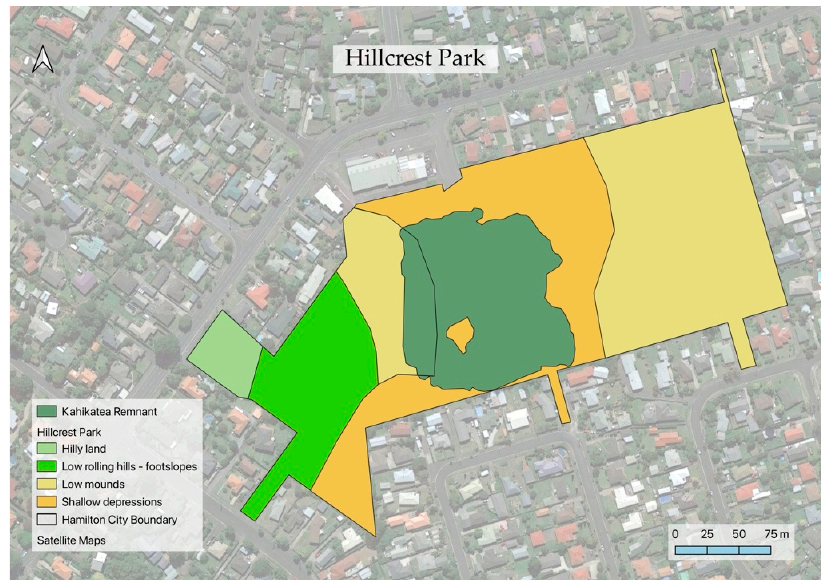
Figure A2. Hillcrest Park’s planting zones. Hilly land (rimu/tawa forest); low rolling hills— footslopes (pukatea-kahikatea forest); low mounds (mixed conifer-broadleaf forest) and shallow depressions (kahikatea semi-swamp forest). Pioneer species of the alluvial plains include Cordyline australis , Melicytus ramiflorus , and Myrsine australis . Alternatively, pioneer species of the hills include Hedycarya arborea , Podocarpus totara and Alectryon excelsus